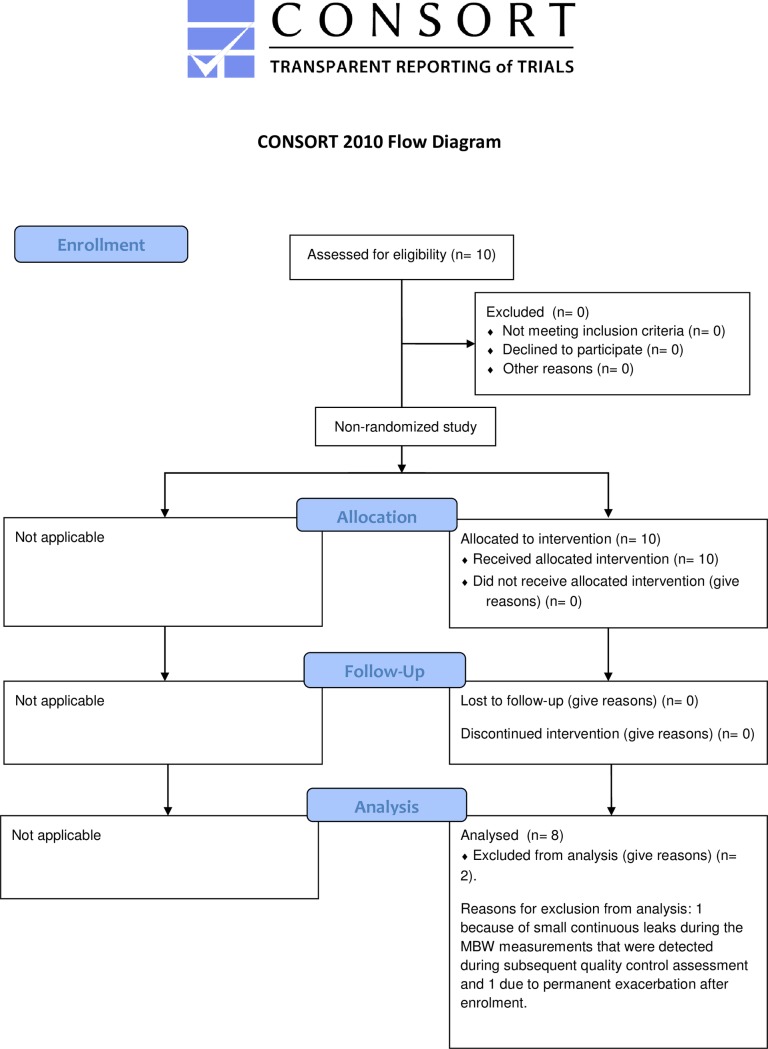
Study flow diagram using the CONSORT 2010 standard.